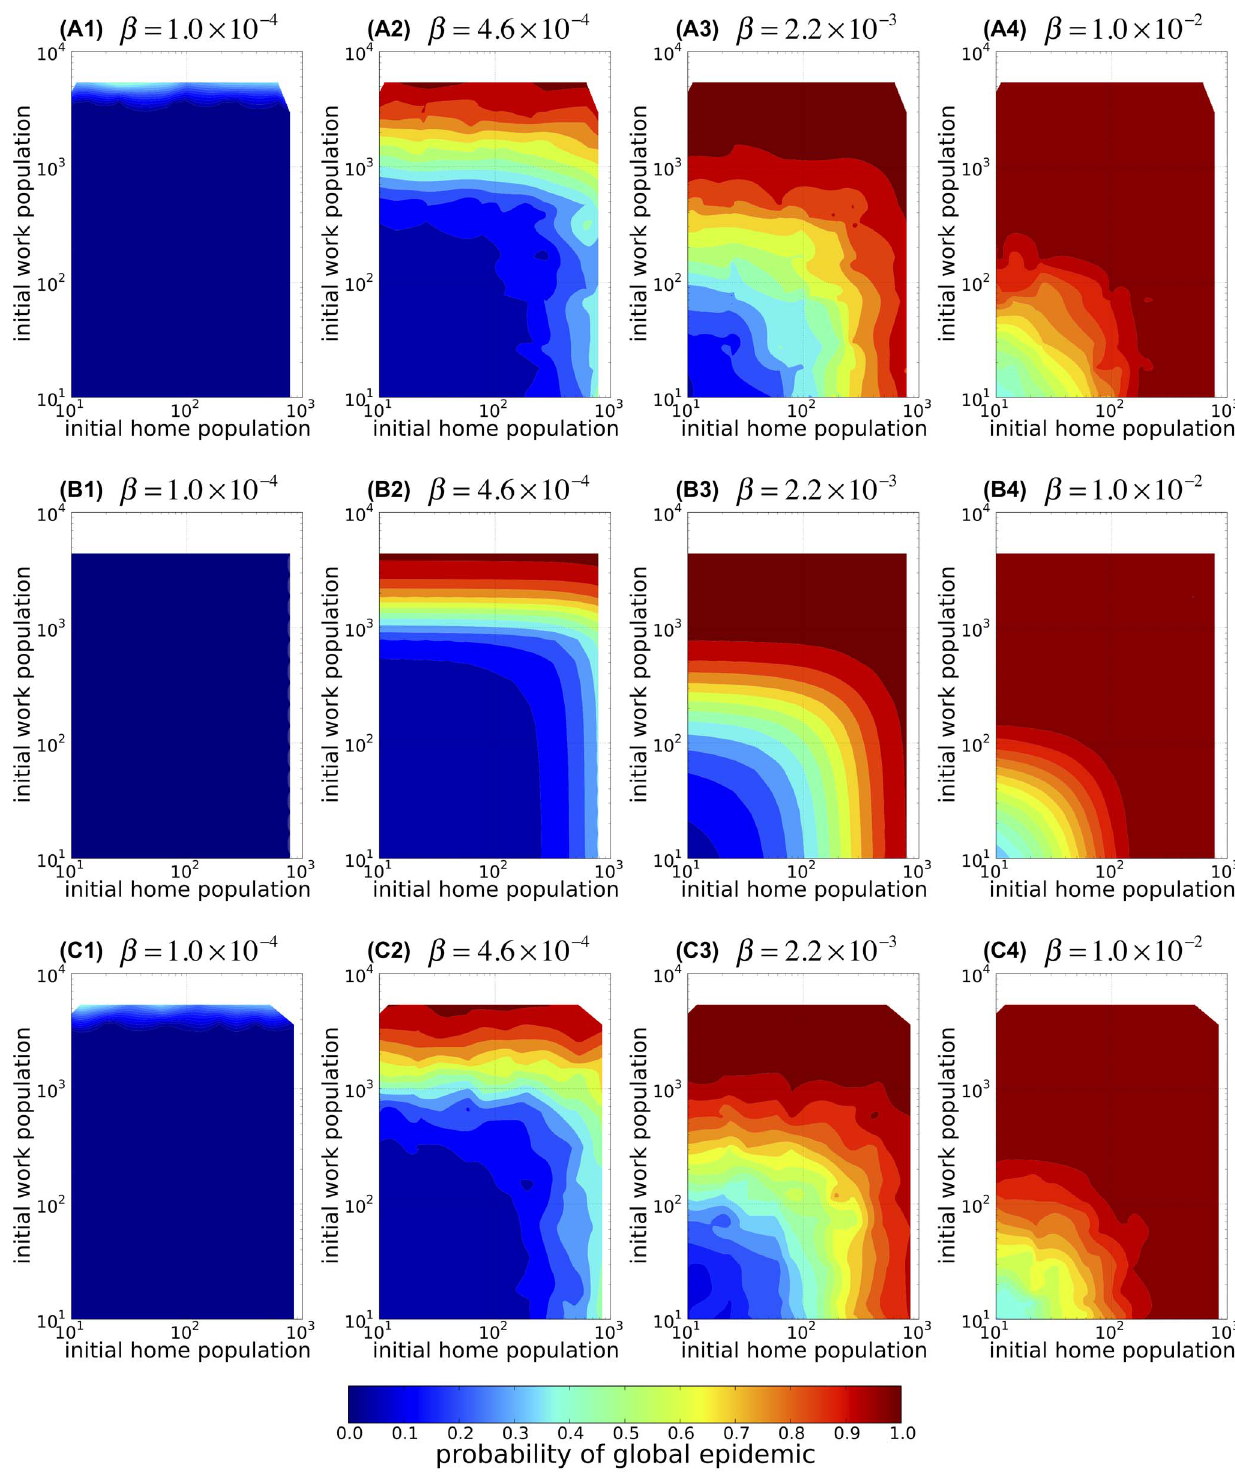
Figure 3. The probability that a single infected host causes global epidemic. The probability of a global epidemic, P G , as a function of the home population size (horizontal axis; initial home population) and work population size (vertical axis; initial work population) of the initially infected host for various infection rate b . (A1–4) The results of the individual-based model (IBM) simulations of the spread of infectious disease over the commute network of the Tokyo metropolitan area which starts with a single infectious individual commuting from a randomly chosen home population to a randomly chosen work population. Each panel corresponds to a different infection rate, and the population sizes are plotted on logarithmic scales. (B1–4) The corresponding results obtained using a branching process formula in the population size class model (PSCM). (C1–4) The corresponding results of the IBM simulations using the random reconnection model (RRM). In each panel, the contour plot represents interpolation of the results calculated using the data of 184 combinations of initial home and work population sizes.